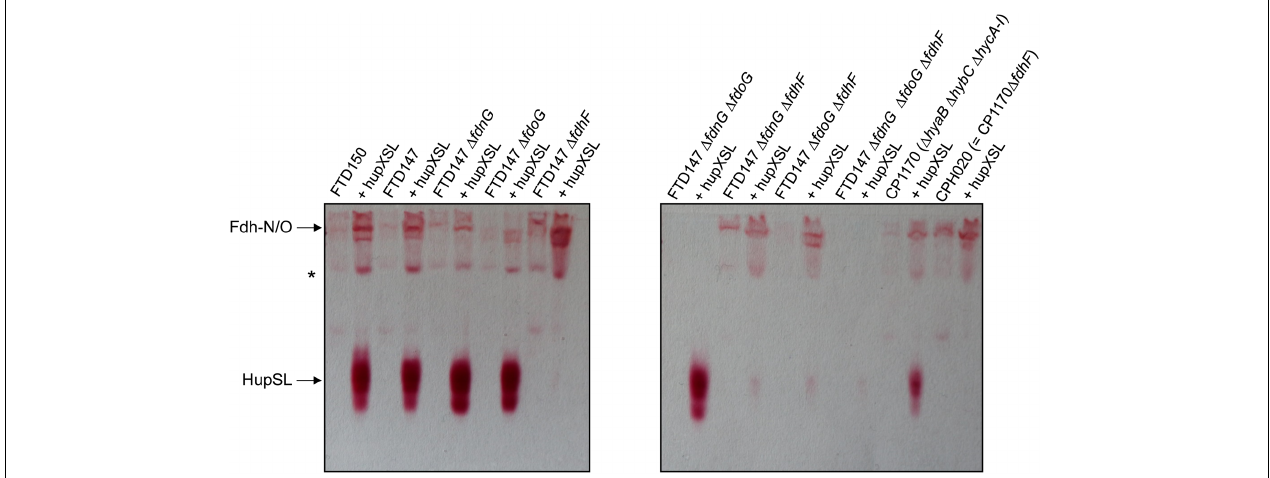
FIGURE 4 | Only strains lacking Fdh-H, the product of the fdhF gene, failed to show HupSL enzyme activity. Crude extracts (90 µ g of protein) of the indicated strains were separated in native-PAGE and stained for hydrogenase enzyme activity as described in the legend to Figure 1 . The asterisk denotes a fast-migrating form of the Fdh-O enzyme (Hartwig et al., 2015a). Strains used include: FTD147 ( (cid:49) hyaB (cid:49) hybC (cid:49) hycE ), plus its deletion derivatives; FTD150 ( (cid:49) hyaB (cid:49) hybC (cid:49) hycE (cid:49) hyfG ); CP1170 ( (cid:49) hyaB (cid:49) hybC (cid:49) hycA-I ); CPH020 ( (cid:49) hyaB (cid:49) hybC (cid:49) hycA-I (cid:49) fdhF ).